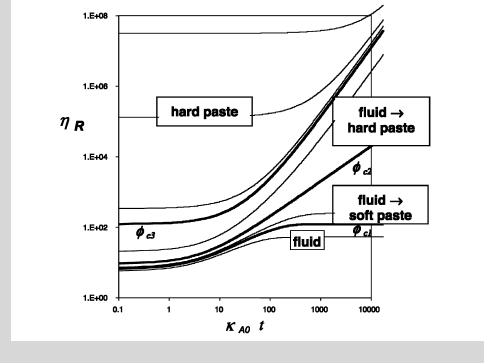
Figure 1 (left): Evolution of the effective volume fraction versus the reduced time k t. The A0 curves f , f and f divide c1 c2 c3 the domain into sub- domains corresponding to the different states of the system. NLS-model parame- ters: h = 1 mPa·s, f = j = F m 0.637, S = 0.1, k = 10 3 s -1 ). init A0 Figure 2: Relative viscosity versus reduced time k t. The bold A0 curves f , f and f sepa- c1 c2 c3 rate the different domains of behaviour shown in Table 1. From bottom to top, the six intermediate curves cor- respond to f = 0.35, 0.38, 0.47, 0.5, 0.601 and 0.6025. The top two curves with f > f show the extremely c3 rapid variation of the initial value of h as f approaches f . Same values of the NLS- m model parameters were used as for Figure 1. Table 1: Different types of behav-